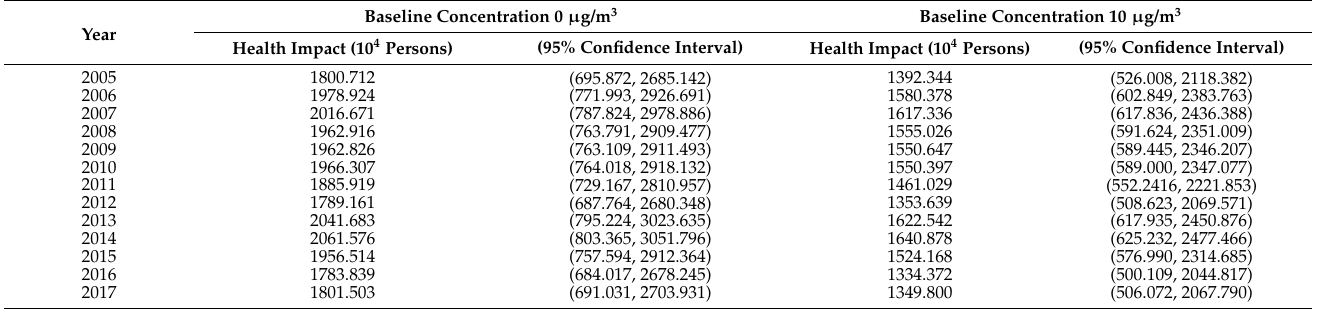
Table 4. The comparison of health impact upon exposure to PM 2.5 at different baseline concentrations.